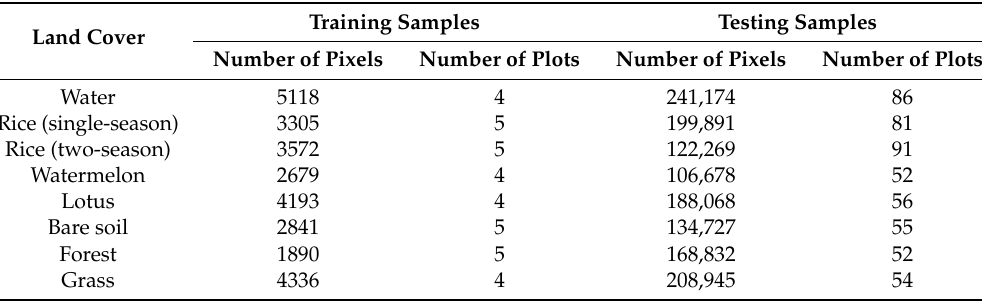
Figure 2. The training ( left ) and testing ( right ) samples in the study area. Table 3. Field data collected for classification training and testing.